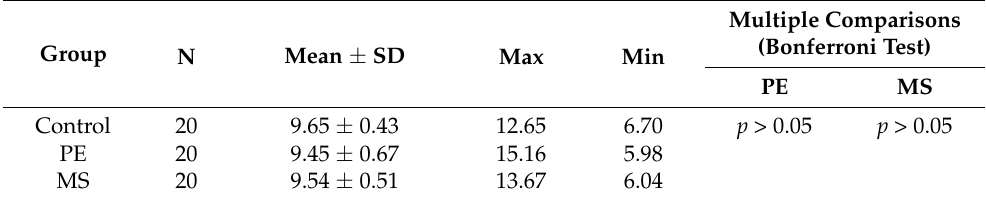
Table 1. Statistical descriptions and outcomes of the Bonferroni test for comparing SBS values of the groups (MPa).